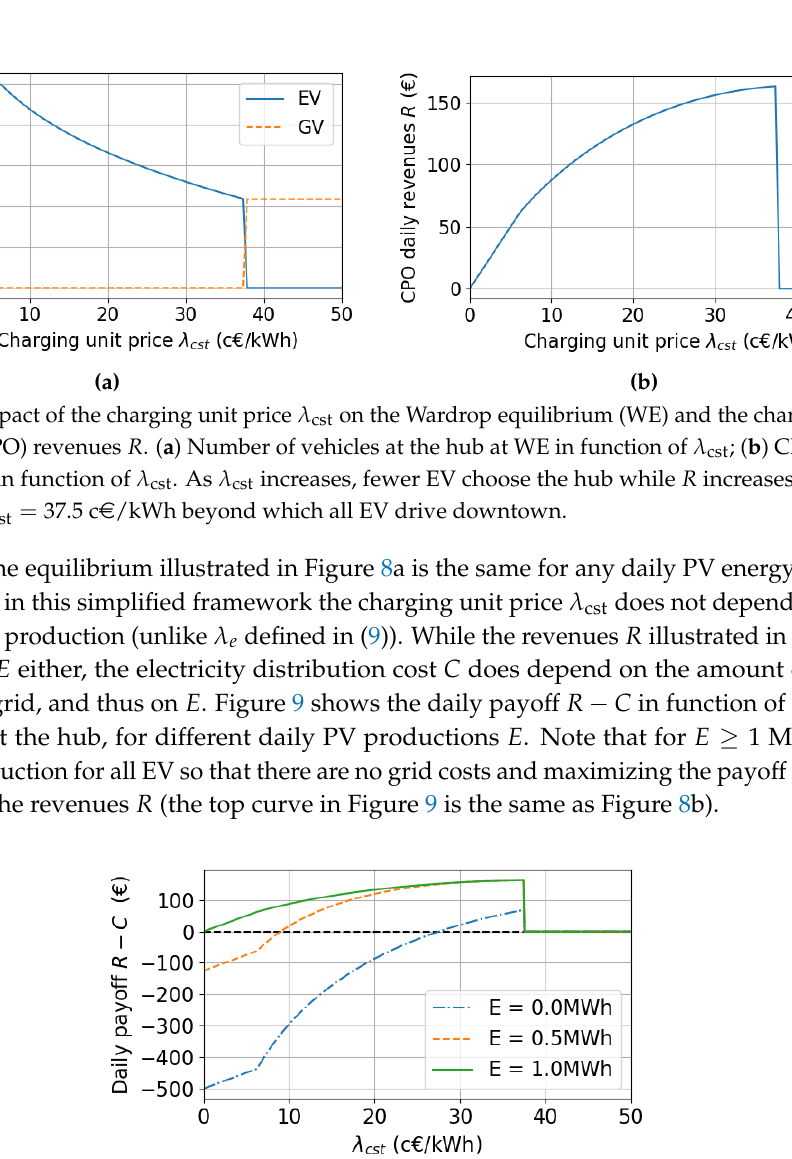
Figure 9. Daily payoff R − C in function of the charging unit price λ cst at the hub, for different daily PV productions E . No matter E , λ cst = λ ∗ cst maximizes R − C